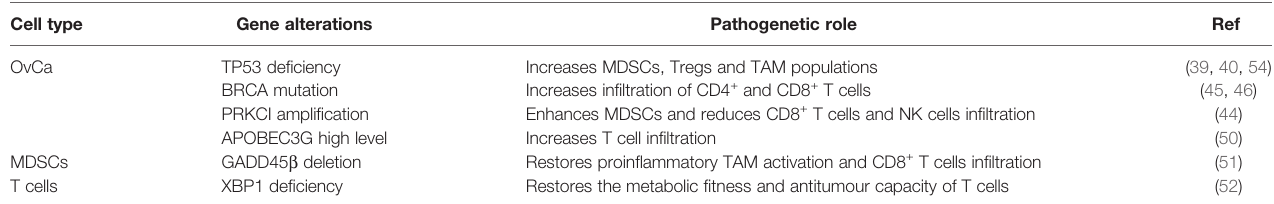
TABLE 1 | Genes regulate immune system in